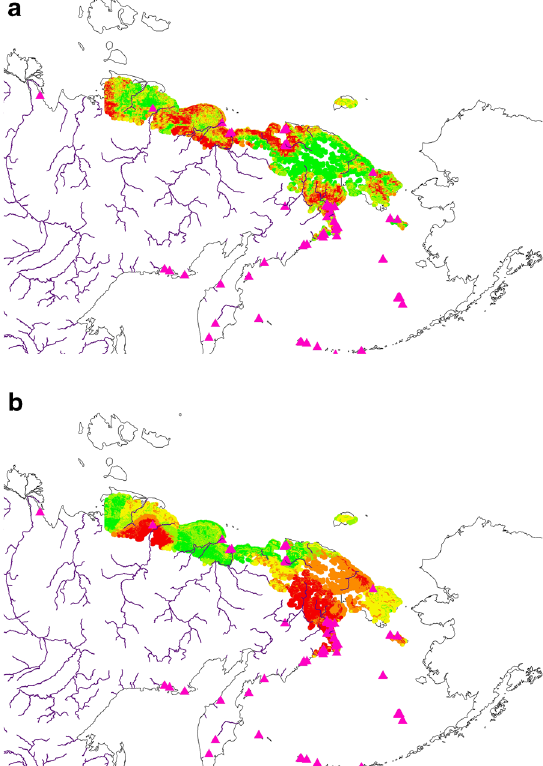
Figure 6. Predictions of Greater White-fronted Goose ( Anser albifrons ) ( a ) parents with broods, and ( b ) moulting nonbreeders for the study area). The map predictions are presented as a ‘heatmap’ of the relative index of occurrence (RIO): red is a high RIO and green is a low RIO. Best-available GBIF presence location for this species are overlaid for assessment; they are shown as pink points. Map created by FH with OpenSource QGIS and ArcGIS Desktop 10.6 academic